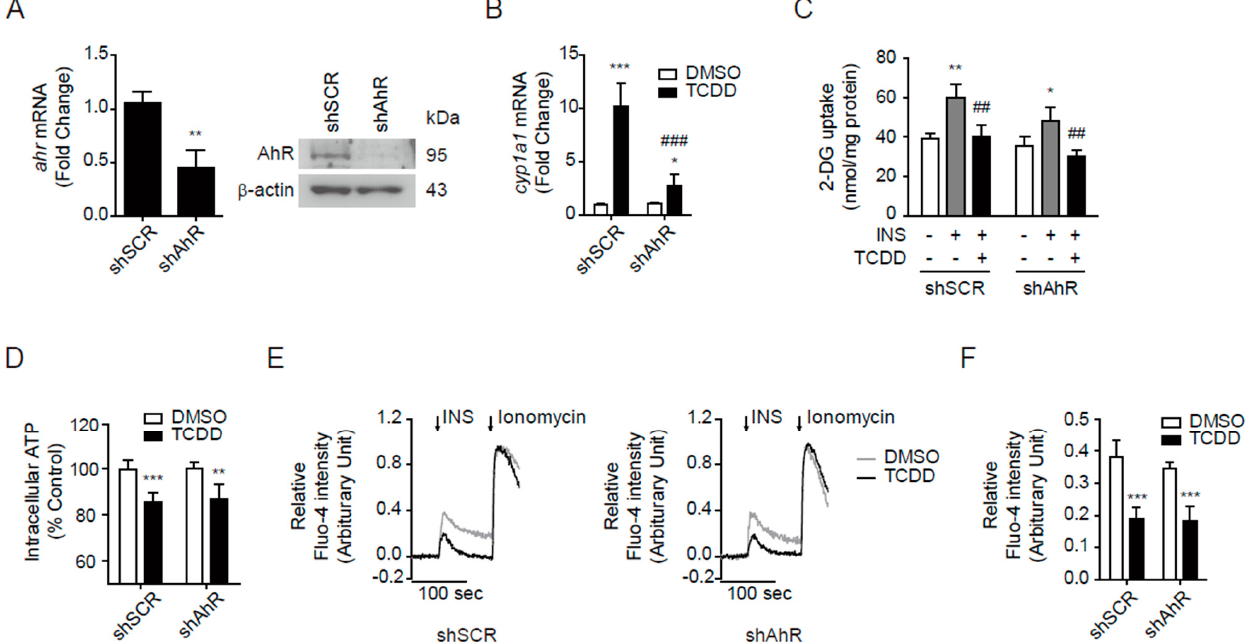
Figure 6. TCDD inhibited insulin-induced glucose uptake in an AhR-independent manner. The shSCR and shAhR C2C12 cells were incubated with DMSO or TCDD (100 pM) for 48 h. ( A ) The mRNA (left panel) and protein (right panel) levels of AhR in shSCR and shAhR cells. ( B ) CYP1A1 induction by TCDD in shSCR and shAhR cells. ( C ) Glucose uptake. The cells were incubated in glucose-free HBSS for 2 h, stimulated by insulin (100 nM, 10 min), and incubated with 2-DG (1 mM, 30 min). The concentration of 2-DG in the cells was measured using an enzymatic assay and normalized to the protein concentration. ( D ) Intracellular ATP contents in TCDD-treated cells were determined using CellTiter-Glo ® . ( E ) The cells were loaded with 3 μ M of Fluo-4 AM for 30 min and sequentially stimulated by 100 nM of insulin and 10 μ M of ionomycin. The fluorescence was monitored using a confocal microscope. ( F ) The insulin-stimulated relative fluorescence intensity was calculated from ( E ). Data are represented as means ± SEM ( n = 3~9). Note: * p < 0.05, ** p < 0.01, *** p < 0.001 vs. DMSO control in shSCR or shAhR cells; ## p < 0.01, ### p < 0.001 vs. INS+ group in shSCR or shAhR cells or TCDD-treated shSCR